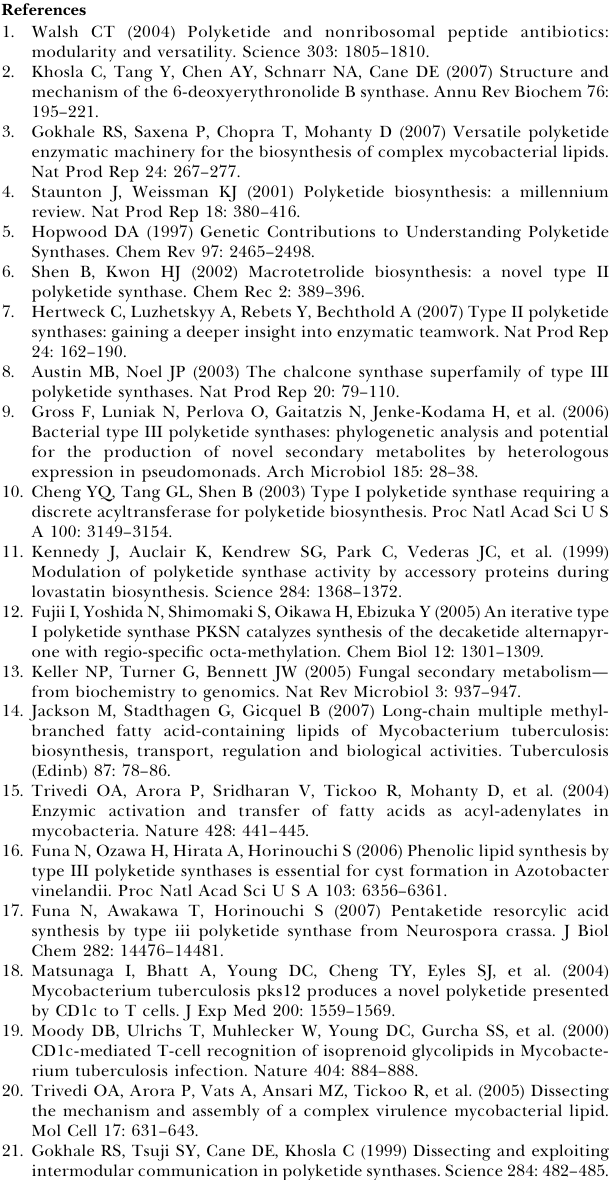
Table S2. List of Primers